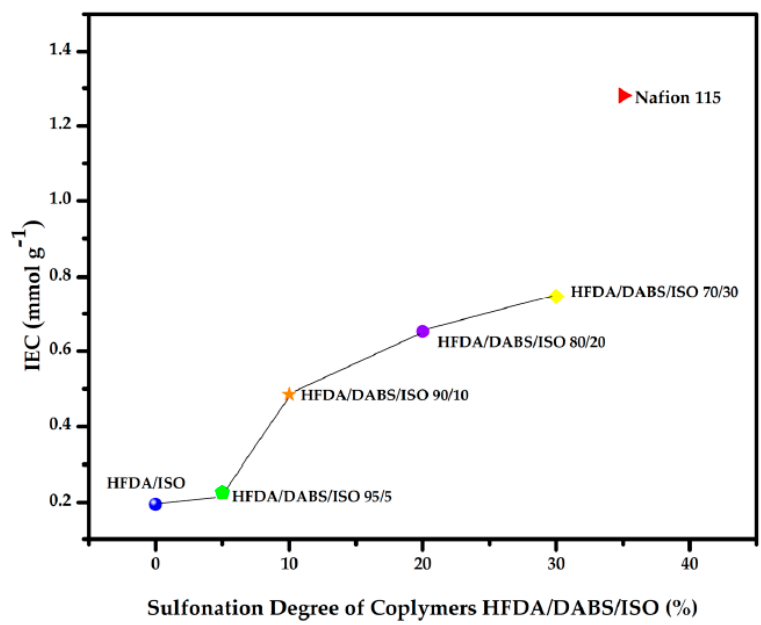
Figure 3. IEC of the membranes HFDA / ISO and HFDA / DABS / ISO based on the degree of sulfonation.